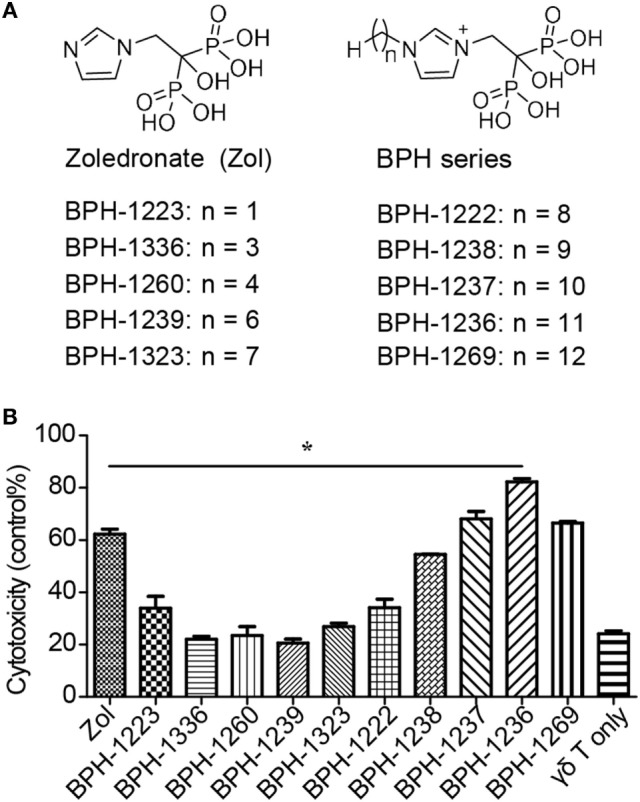
BPH-1236, a lipophilic analog of zoledronate, performs the better killing of activated hepatic stellate cells (aHSCs) by Vγ9Vδ2 T cells. (A) Chemical structures of zoledronate and its lipophilic analogs (BPH series). (B) Specific lysis of LX-2 cells (T) pretreated with various lipophilic BPH series (5 µM) by Vγ9Vδ2 T cells (E) at an E:T ratio of 10; recording of lactate dehydrogenase (LDH) activity. Data are presented as mean ± SEM of three replicates from a representative experiment of two independent experiments. *P < 0.05.